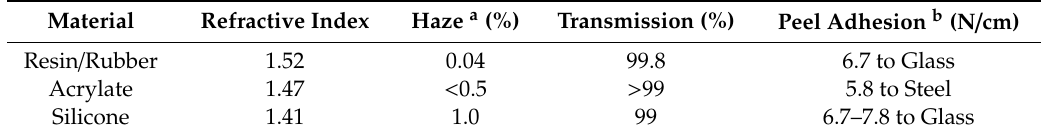
Table 2. Indicative optical and mechanical parameters of adhesive materials used in pressure sensitive adhesive tapes. From [54]. Values can vary depending on the particular